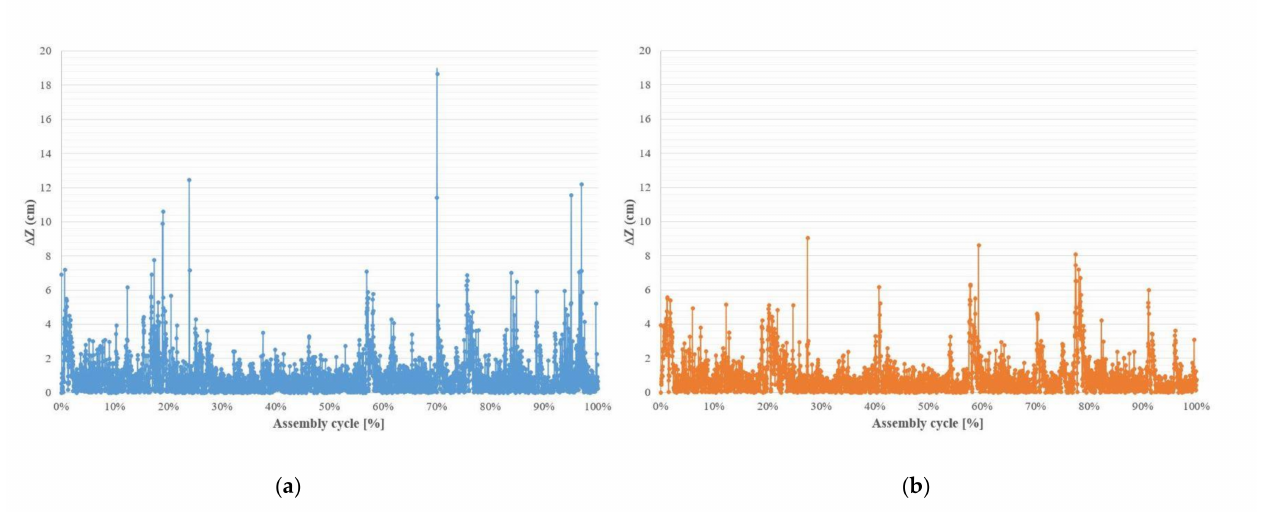
Figure 9. Variations along the z -axis of the right hand for ( a ) Configuration #1 and ( b ) Configuration #2.